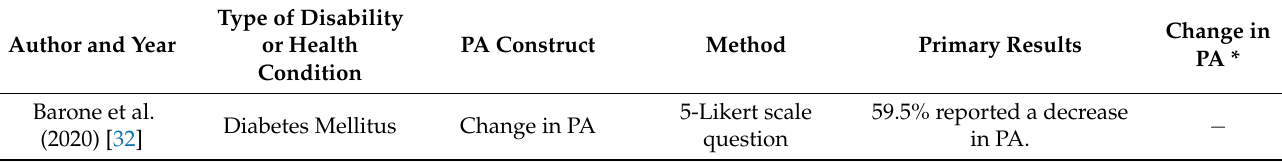
Table 3. Key findings regarding physical activity during the first wave of the COVID-19